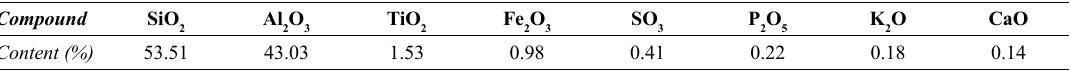
Table 1. Chemical composition of